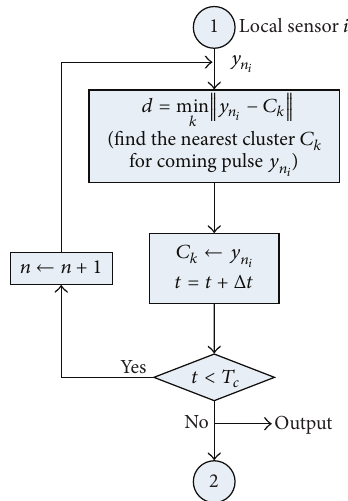
Figure 4: The procedure of local processing. In each sensor, the is attributed to the nearest cluster center 𝐶 𝑘 coming pulse 𝑦 𝑛 𝑖 according to the minimum distance. If the time increment counter reaches a preset threshold 𝑇 , the results are sent to the fusion center. In addition, the results would be output to the local control center in time if